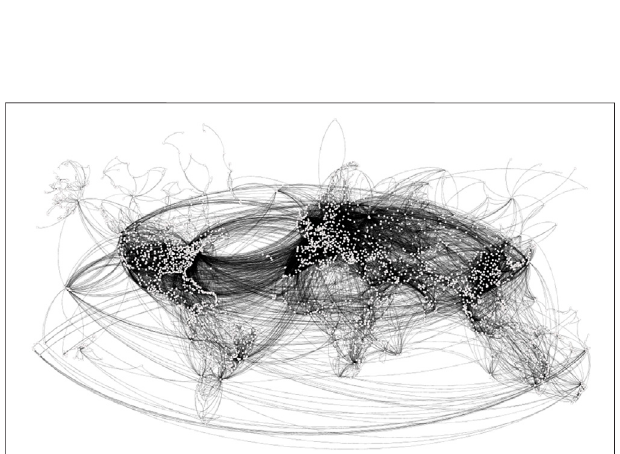
FIGURE 3 | Air transportation